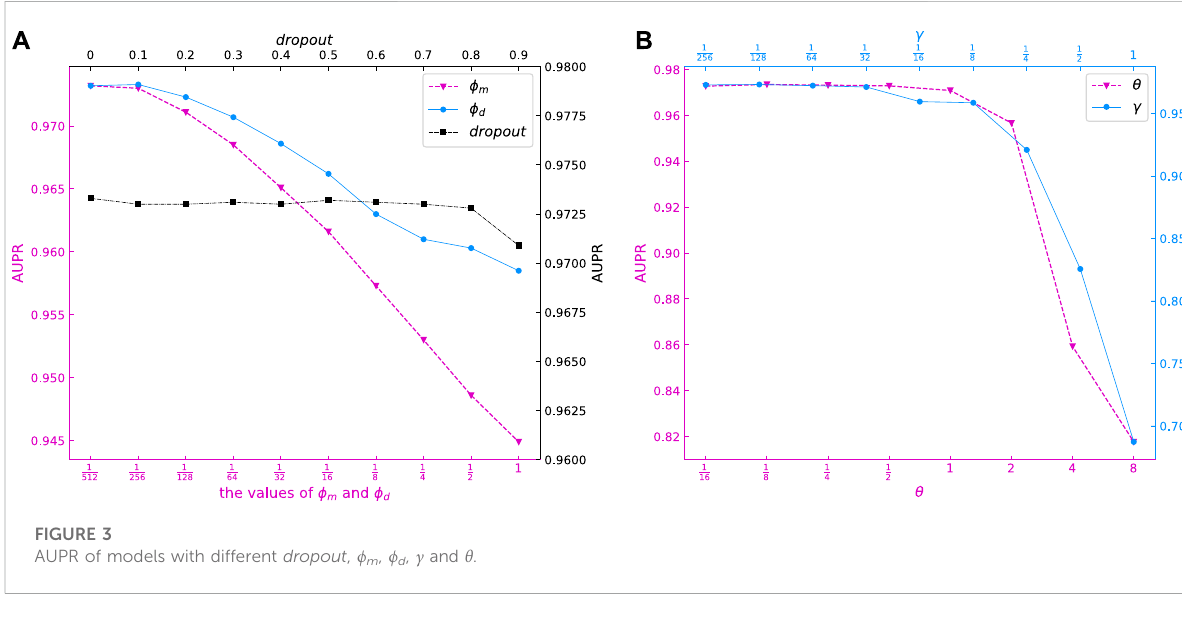
FIGURE 3 AUPR of models with different dropout , ϕ m , ϕ d , γ and θ .